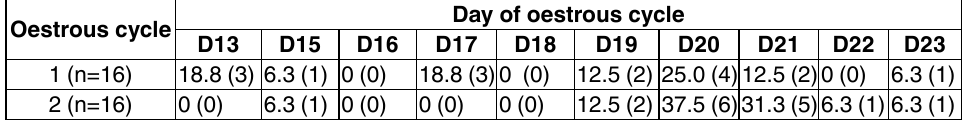
Day of oestrous